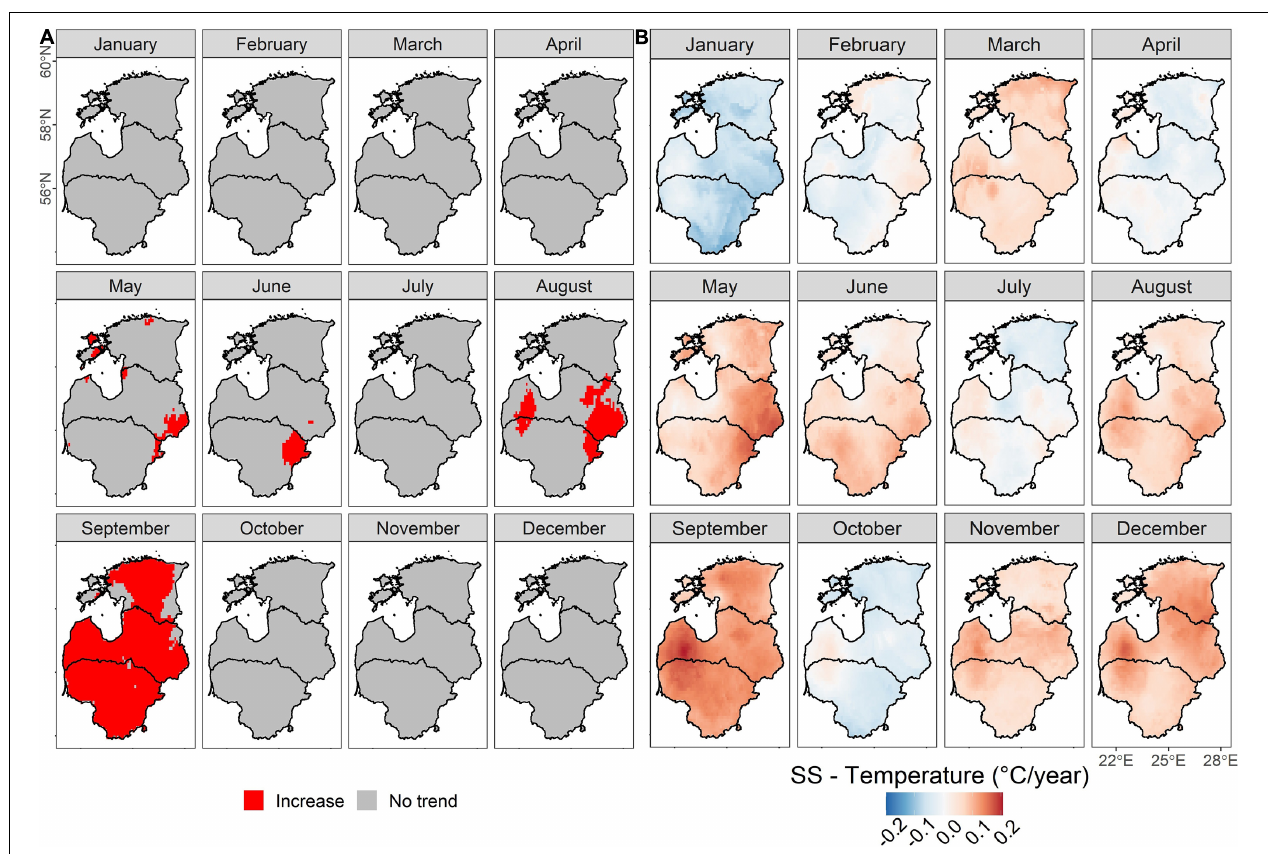
FIGURE 3 | (A) Mann-Kendall trend analysis for monthly mean air temperature at a pixel level. (B) Sen’s slope values for monthly mean air temperature. Positive values represent a temperature increase, and negative values represent a